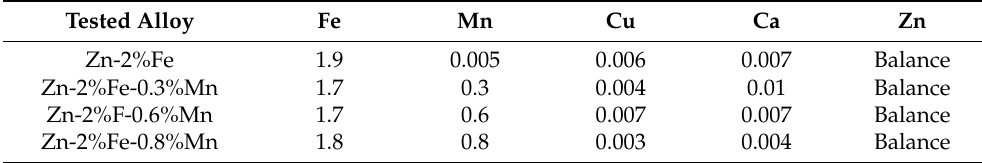
Table 1. The chemical composition of the tested alloys (wt.%). Tested Alloy Fe Mn Cu Ca